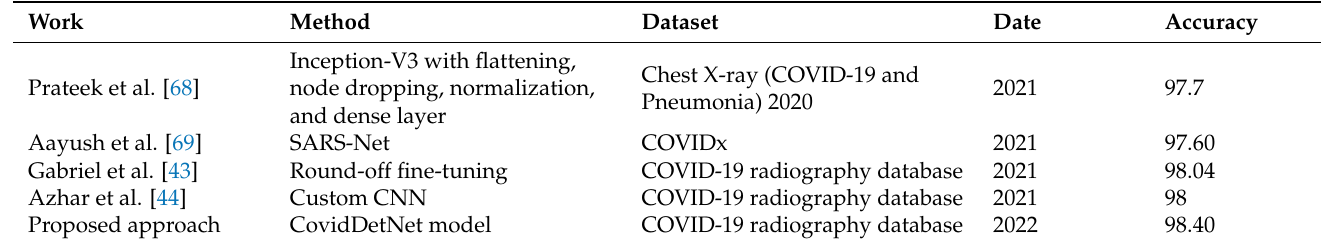
Table 11. COVID-19 detection using chest radiographs comparison with existing